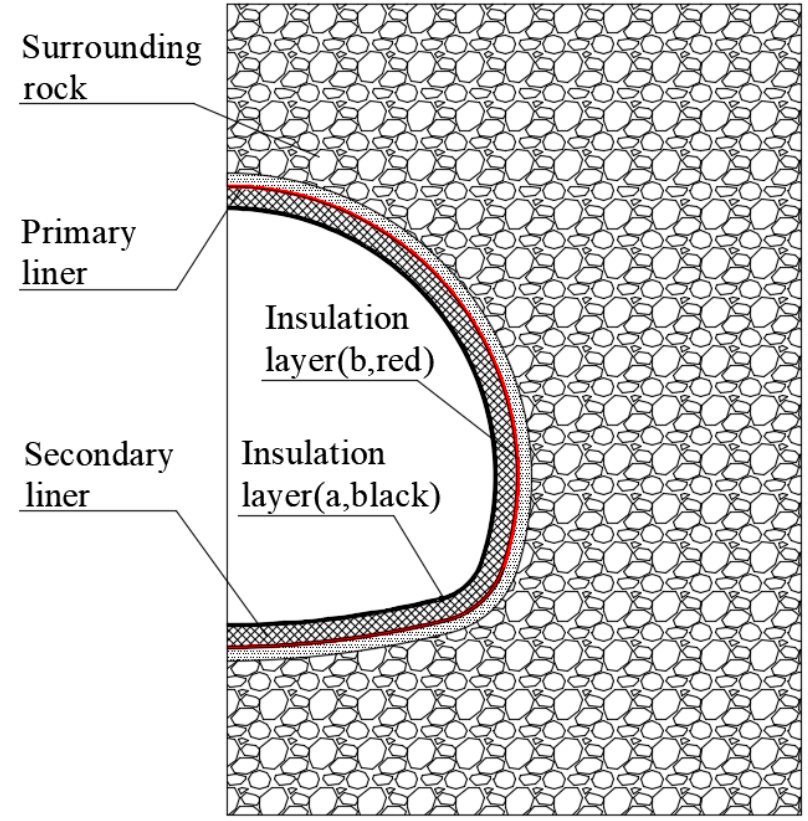
Figure 3. Layout of insulation layers (Drawed by Y.F. Zhou).